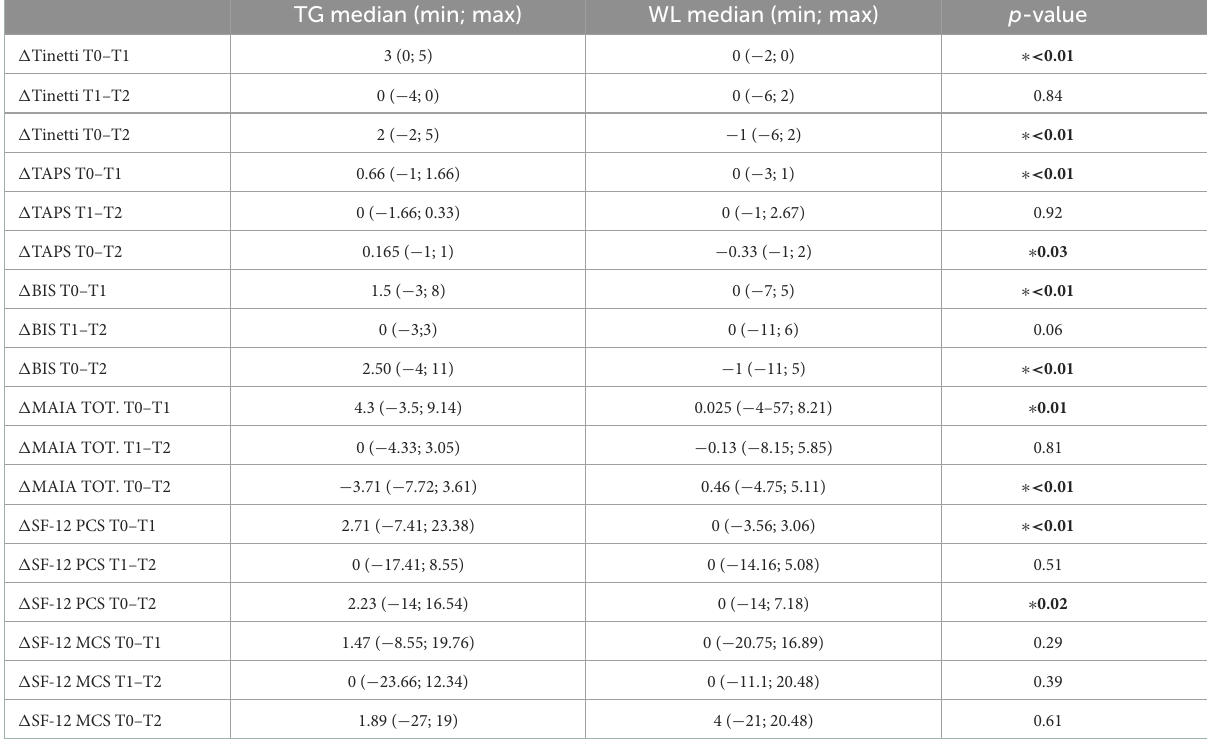
TABLE 4 The variations over time (Delta- 1 ) for all